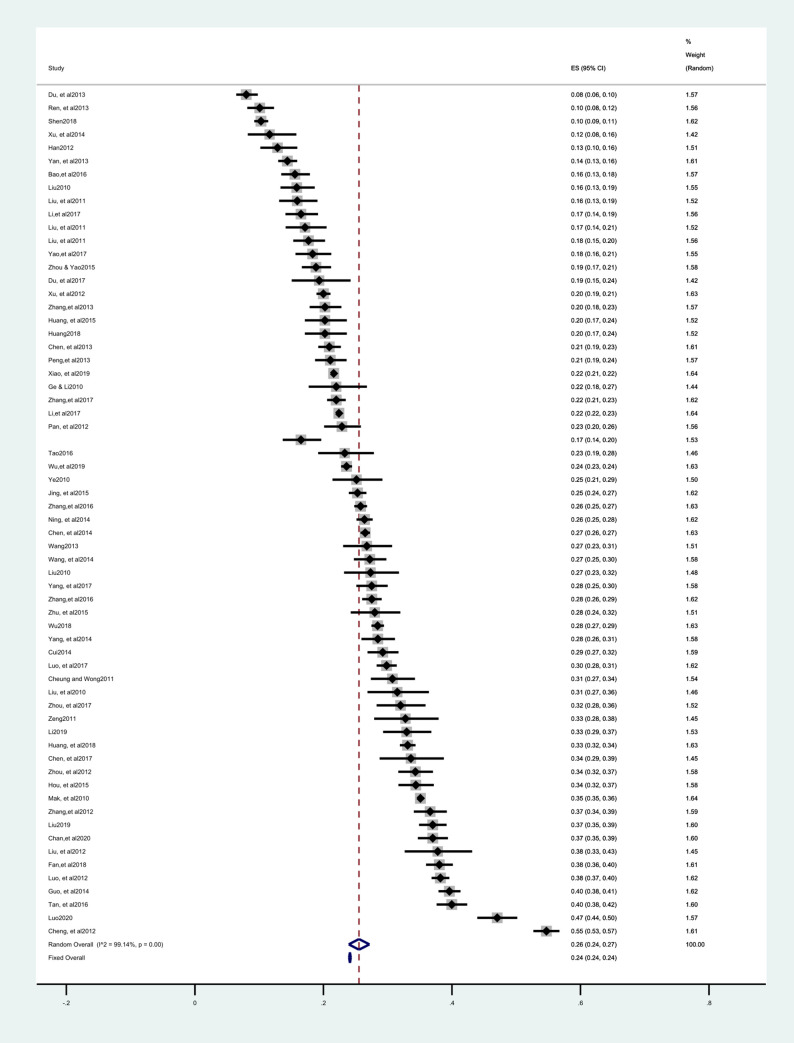
Forest plot of pooled estimates for prevalence.